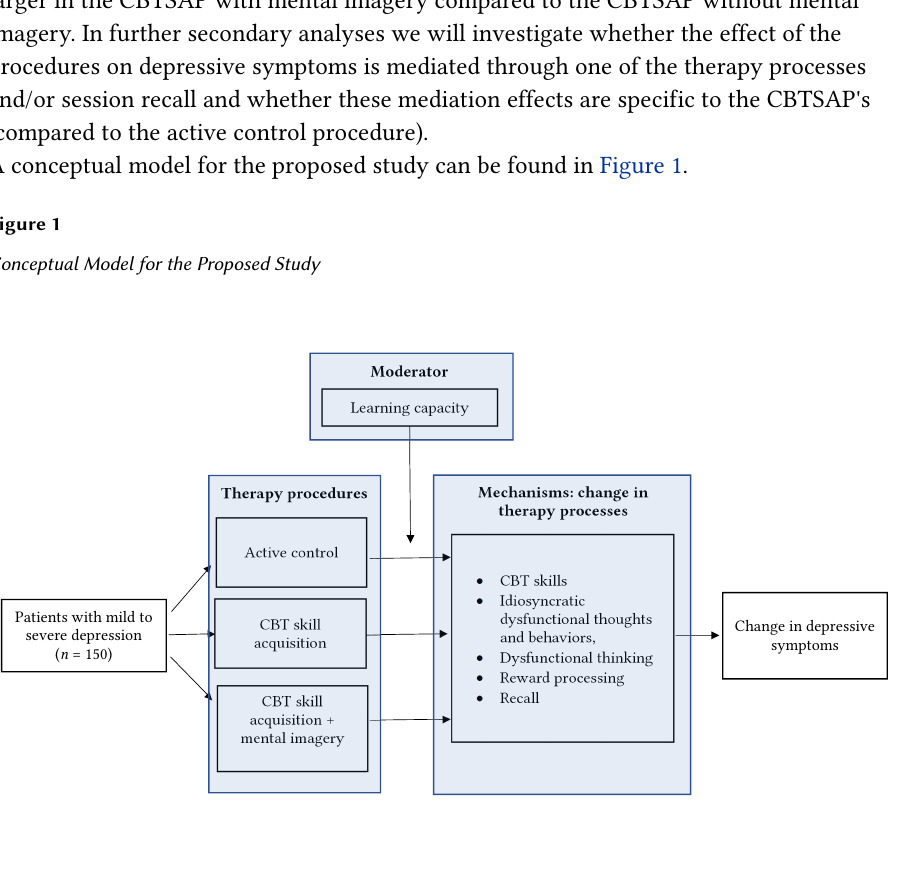
Patients with mild to severe depression Methods ( n = 150)